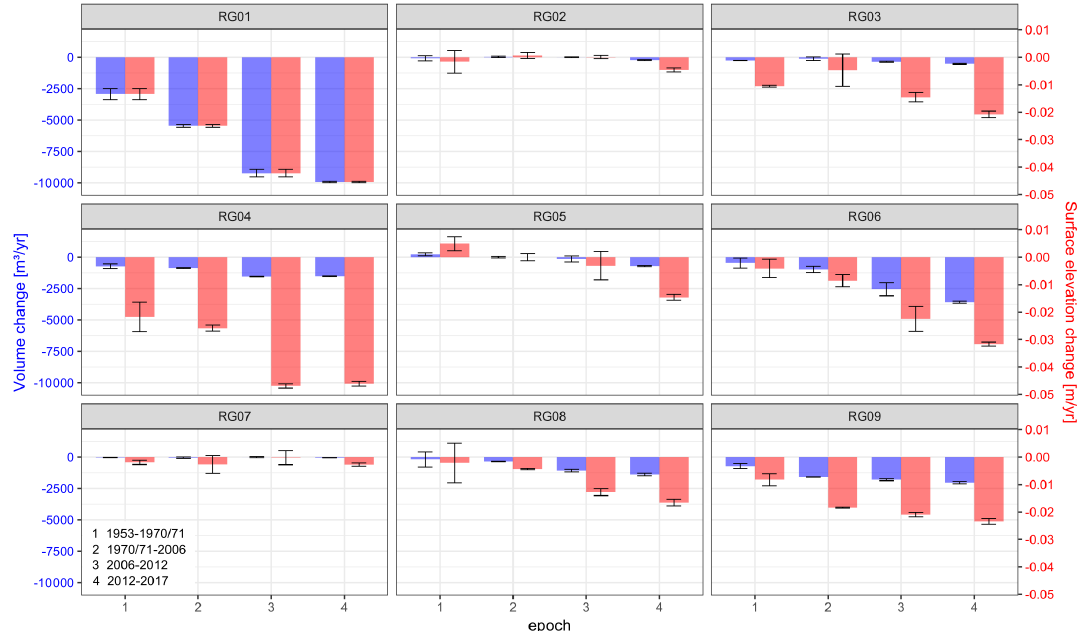
Figure 9. Mean annual volume change and mean annual surface elevation change in the individual rock glaciers for four epochs between 1953 and 2017. Black error bars give the uncertainty in